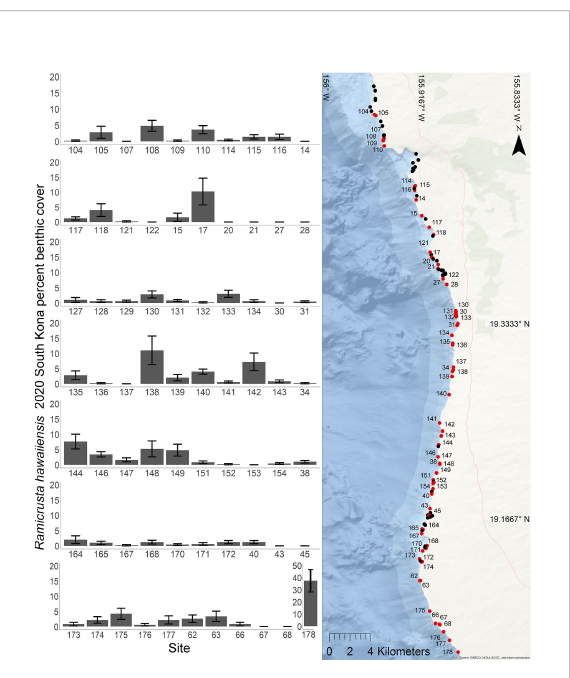
FIGURE 8 Geographic distribution and percent benthic cover of Ramicrusta at South Kona sites in 2020. Map of the 112 South Kona Intensive (SKI) sites in South Kona (right). Ramicrusta was present at 71 sites shown in red, but absent at 41 sites shown in black. Average percent cover values with standard error bars for Ramicrusta are ordered by latitude from north to south at the sites (red) where Ramicrusta was observed in the surveys. Note that the scale of the y axis is 0-20% (unlike 0-5% in Figure 4) for all sites, except site 178